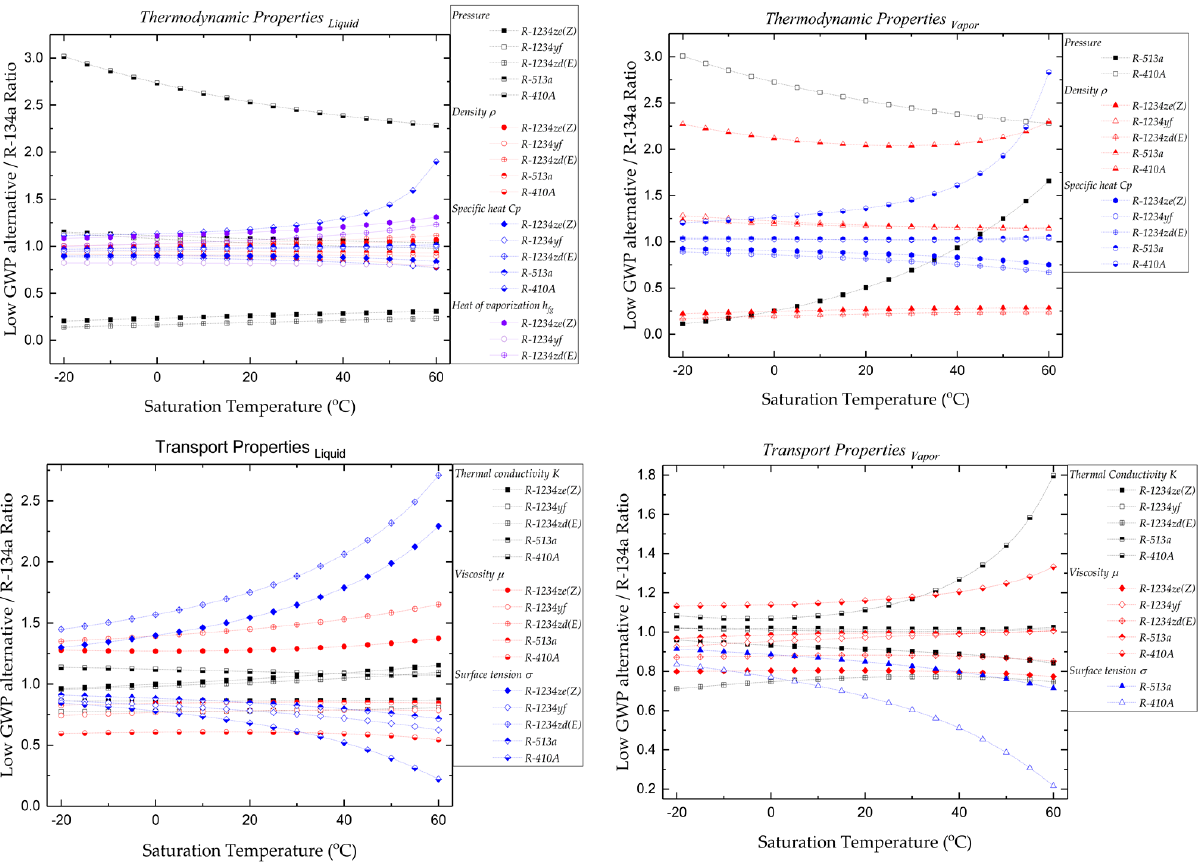
Figure 2. Thermophysical properties of LGWP alternatives to R-134a [3] .